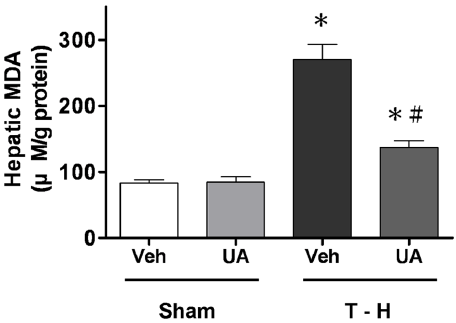
Figure 4. Effects of ursolic acid (UA) treatment on malondial- dehyde (MDA) concentration in rats at 24 hr after sham operation (Sham) or trauma-hemorrhagic shock (T-H). Rats were administered with either vehicle (Veh) or UA. Data are expressed as mean 6 SEM of (n=6). * p , 0.05 compared to Sham; # p , 0.05 compared to T–H + Veh.